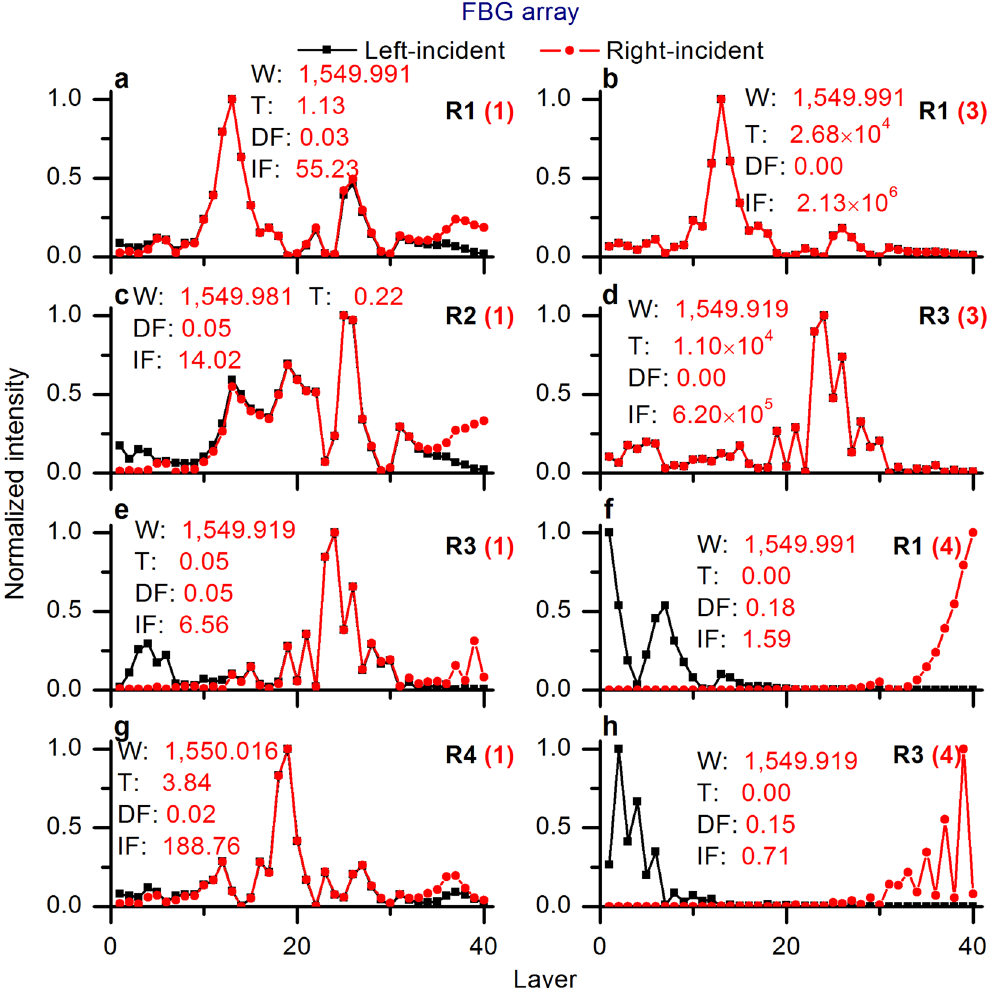
Figure 7. Normalized bi-directional intensity distributions in the optimized FBG arrays WITH gain. (a ) R1 (optimized disorder 1). ( b ) R1 (optimized disorder 3). ( c ) R2 (optimized disorder 1). ( d ) R3 (optimized disorder 3). ( e ) R3 (optimized disorder 1). ( f ) R1 (optimized disorder 4). ( g ) R4 (optimized disorder 1). ( h ) R3 (optimized disorder 4). W: wavelength in nm, T: transmission, DF: deviation factor, IF: intensity factor; the number in parentheses is the number of the optimized disorder; gain rate: 20